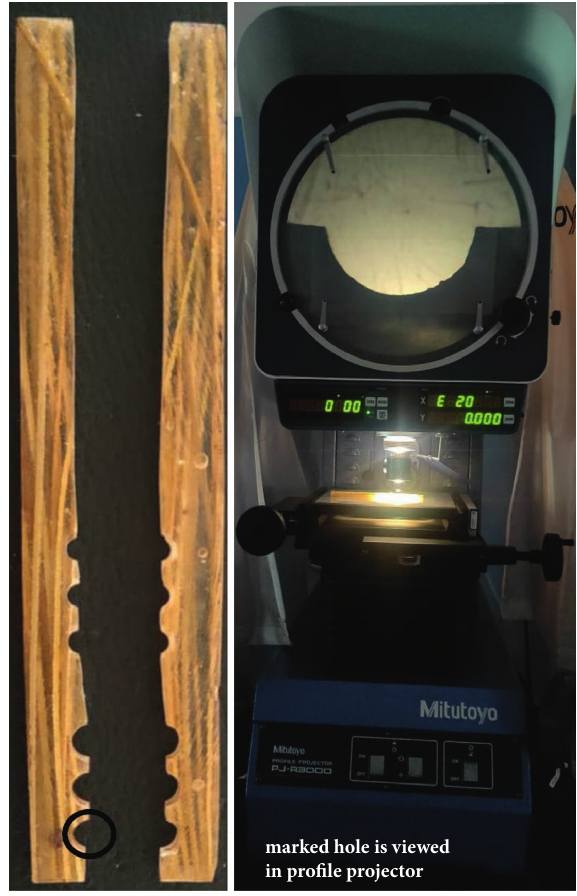
Figure 6: Periphery of the drilled hole is viewed using profile